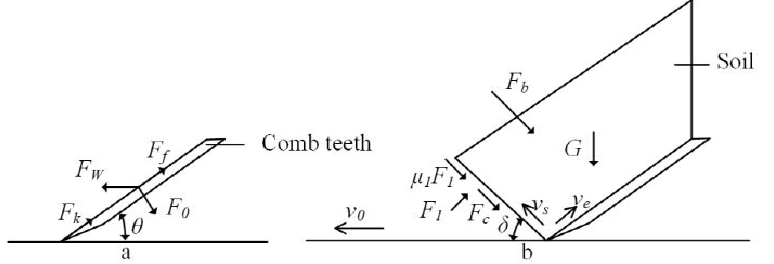
Figure 6. The force analysis diagram of CT in the working process of jujube orchard soil. ( a ) Force analysis of CT in soil working process, ( b ) The force of accumulated soil on CT. Since there are no large stones or residual roots left in the sandy soil environment of the jujube orchard, the cutting resistance F K can be considered as 0. Therefore, during the advancement of the CT, CT will be subject to the stress of sand accumulated on the surface. (Figure 6b). The equilibrium state equation of the sandy soil in the horizontal and vertical directions is as